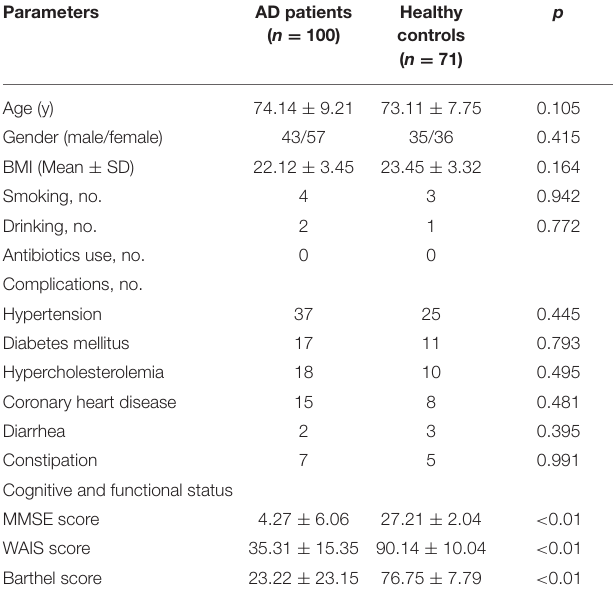
TABLE 1 | Characteristics of the